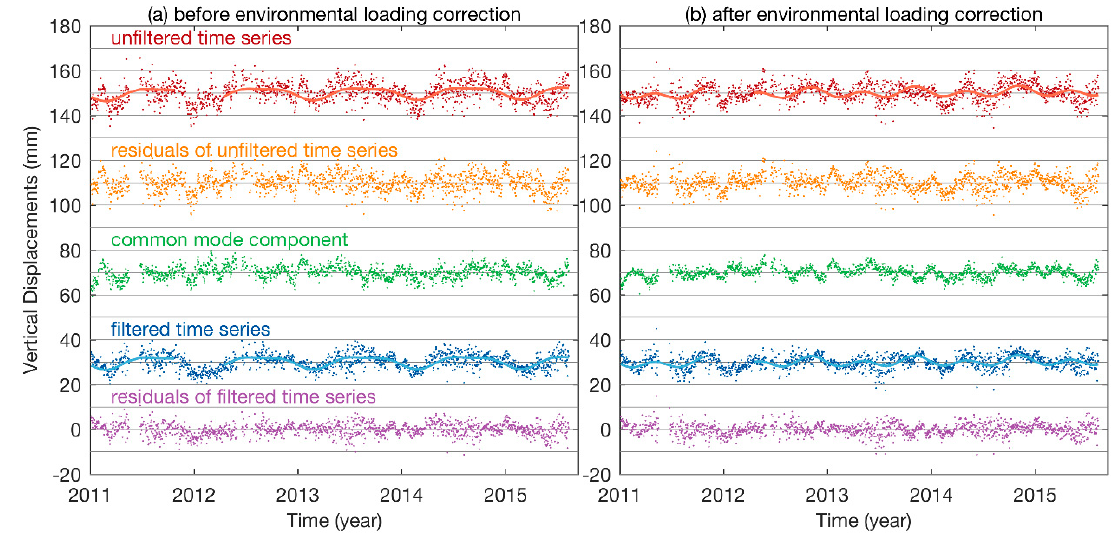
Figure 17. Unfiltered time series (red, shifted upward by 150 mm) and their residual time series (orange, shifted upward by 110 mm) obtained with Equation (1), common mode error (green, shifted upward by 70 mm), and filtered time series (blue, shifted upward by 30 mm), and their residual time series (purple) obtained with Equation (1) for the vertical displacement time series of station Wuqia (XJWU, 39.7°N, 75.2°E) before ( a ) and after ( b ) environmental loading correction.